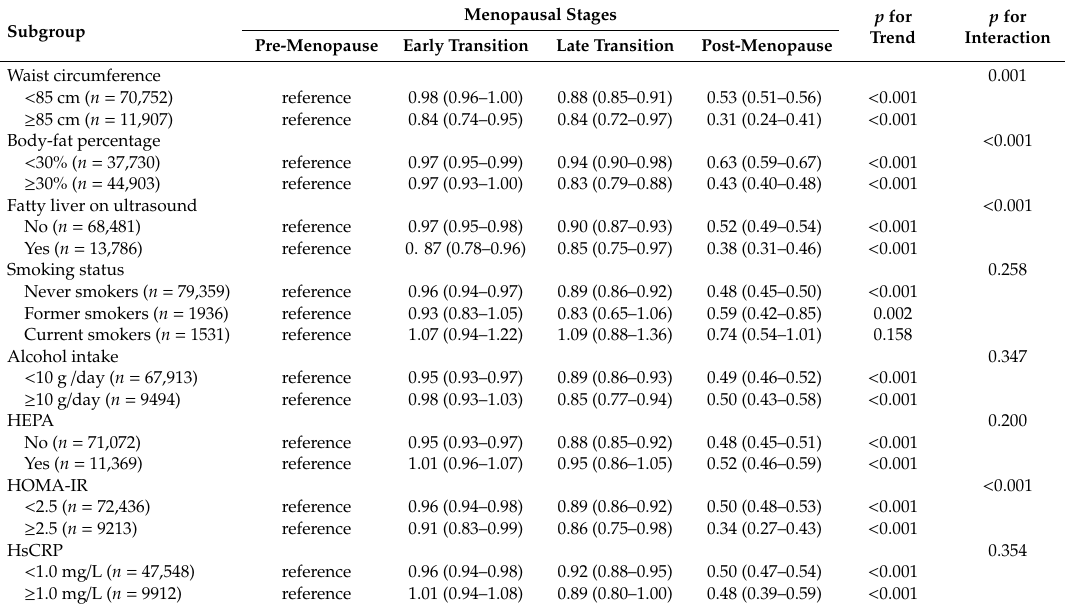
Table 3. Dense-breast prevalence ratios according to menopausal stage in clinically relevant subgroups.